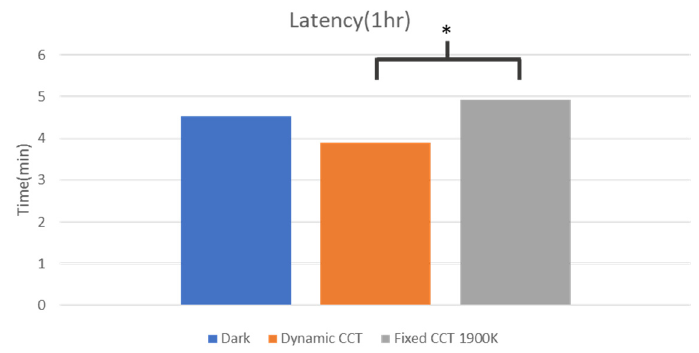
Figure 26. Bracelet sleep latency analysis (* p < 0.05).